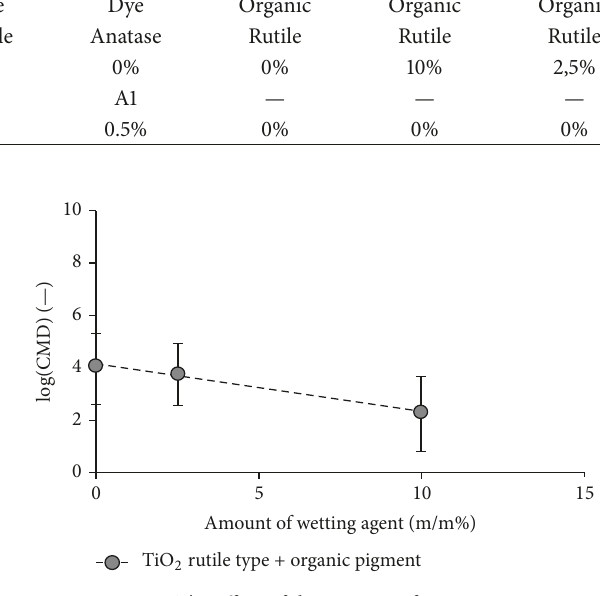
Figure 7: The effect of the amount of wetting